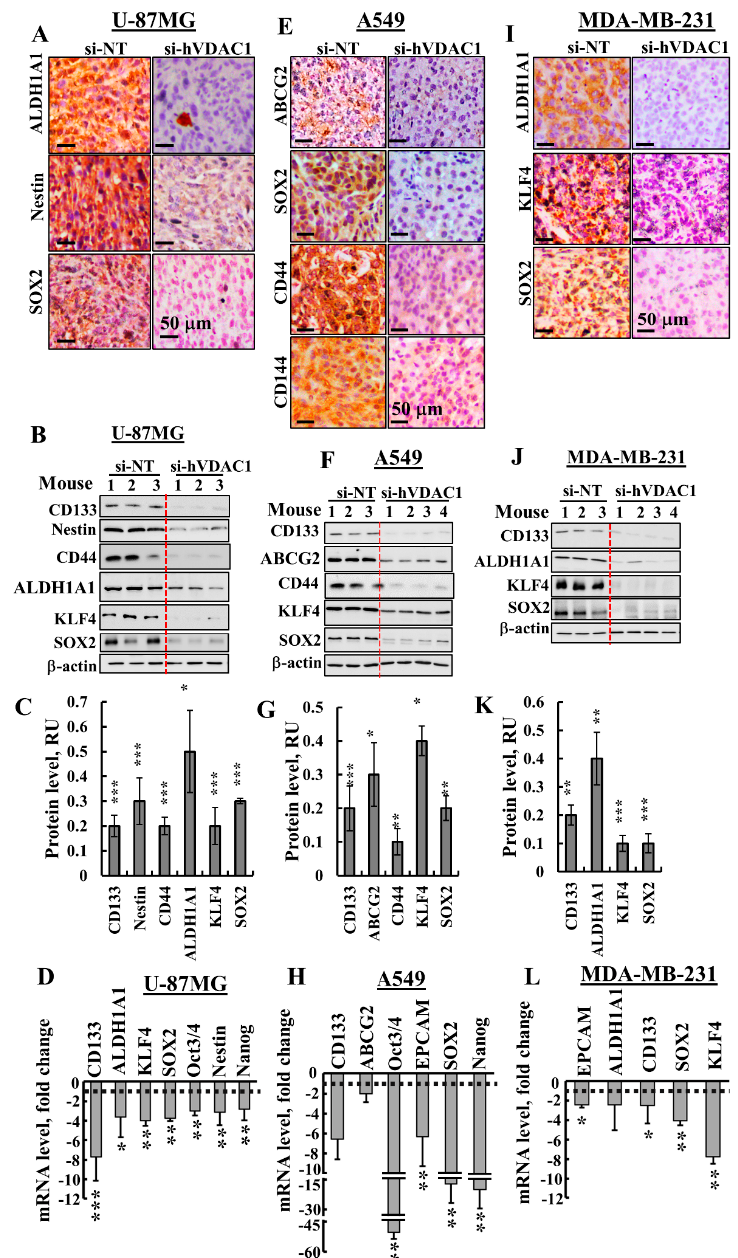
Figure 4. si-hVDAC1 treatment markedly reduces cancer stem cell marker expression in U-87MG-, A549- and MDA-MB-231-derived tumours. Representative IHC staining with cell line-specific CSC markers using specific antibodies in si-NT-TT or si-hVDAC1-TT sections derived from U-87MG ( A ), A549 ( E, ) and MDA-MB-231 ( I ) xenografts. Immunoblot of protein extracts obtained from